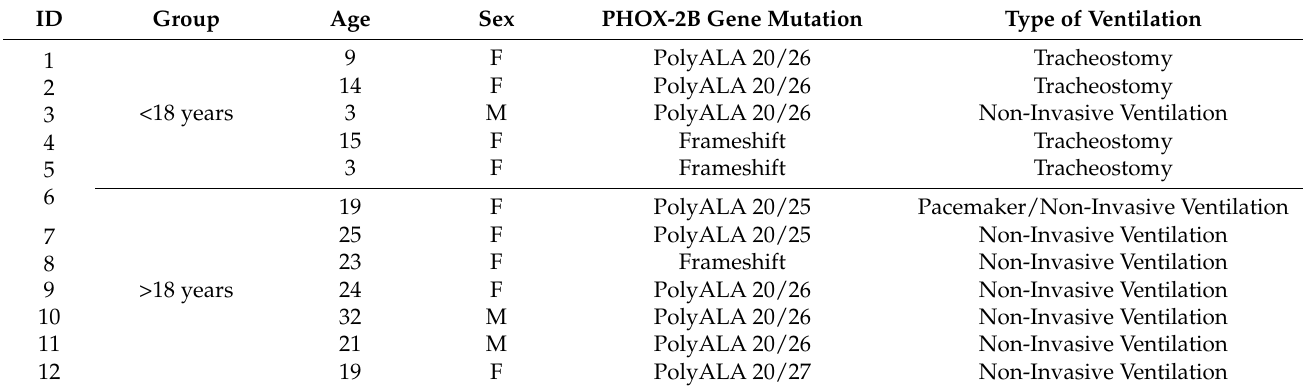
Table 1. Demographic and clinical characteristics of enrolled CCHS